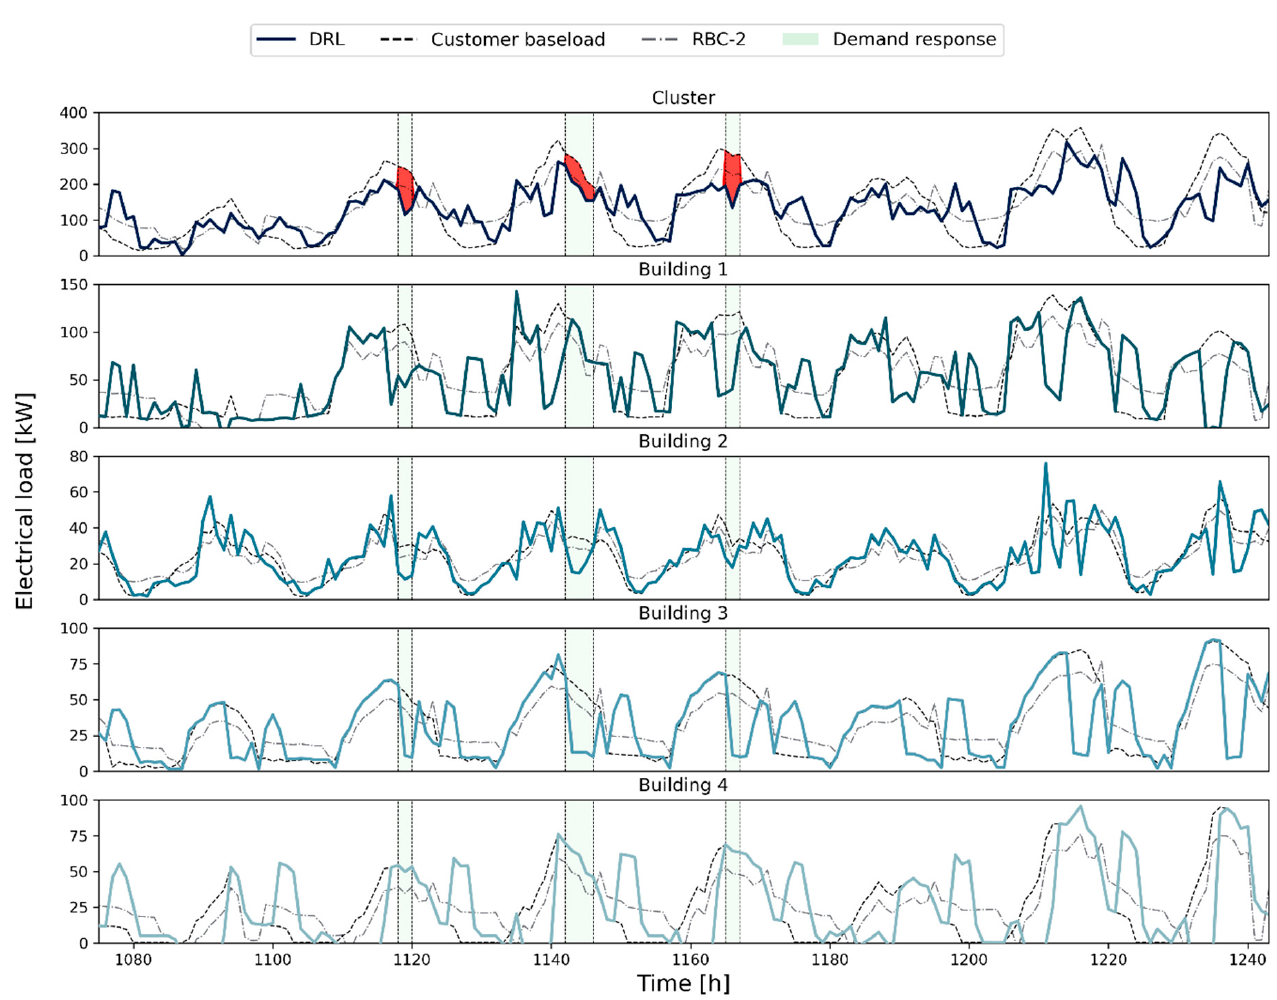
Figure 9. CBL, RBC-2, and DRL electrical load comparison.